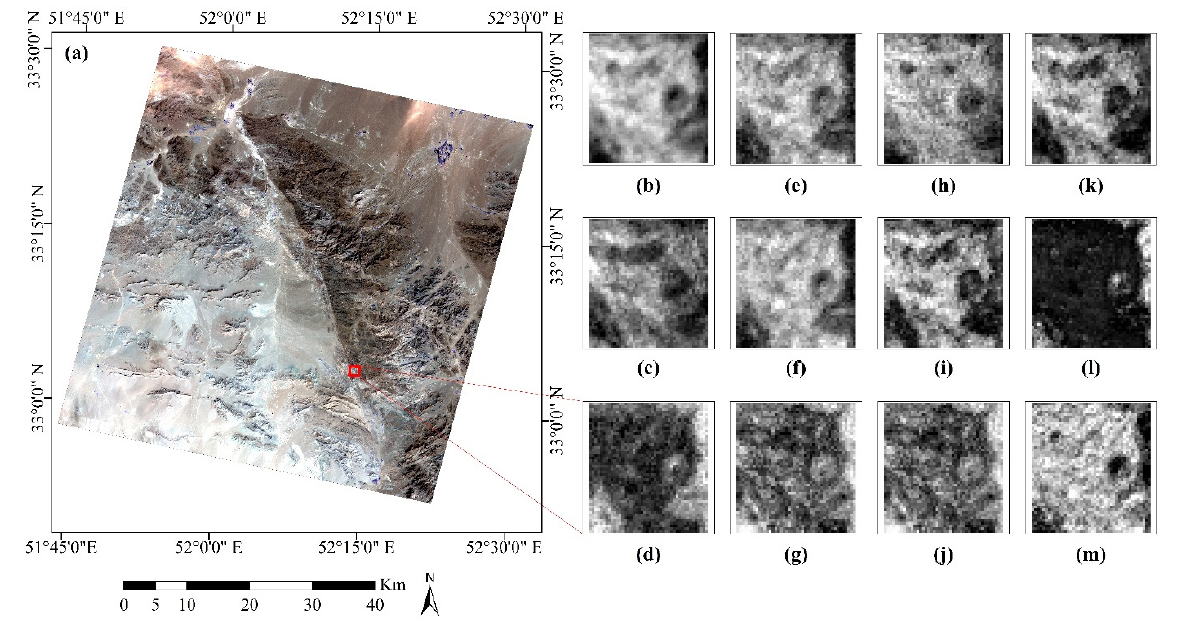
Figure 3. ( a ) Color composite of ASTER (R:3, G:2, B:1); ( b – d ) Phyllic, argillic and propylitic alteration results of the RBD method; ( e – g ) alteration results of the LSU method; ( h – j ) show mapping of phyllic, argillic and propylitic alterations using the OSP; ( k , l ) are the results of the SFF method; ( m ) shows the Fe-oxide alteration.